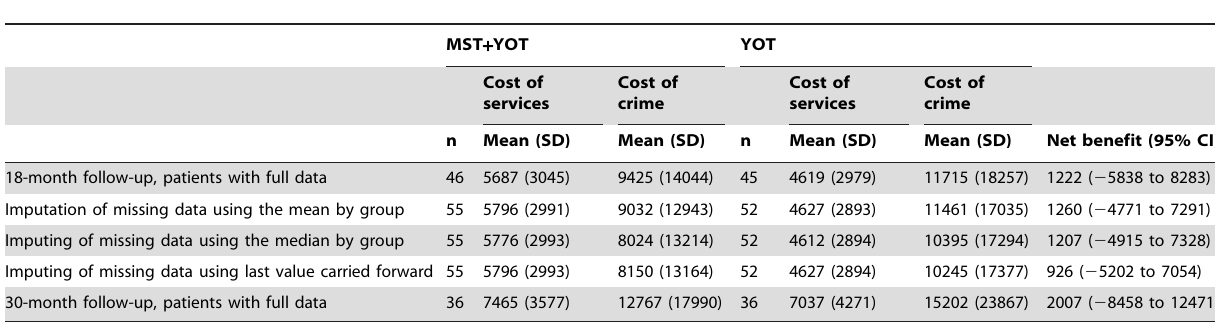
Table 3. Cost-offset and sensitivity analyses (£).